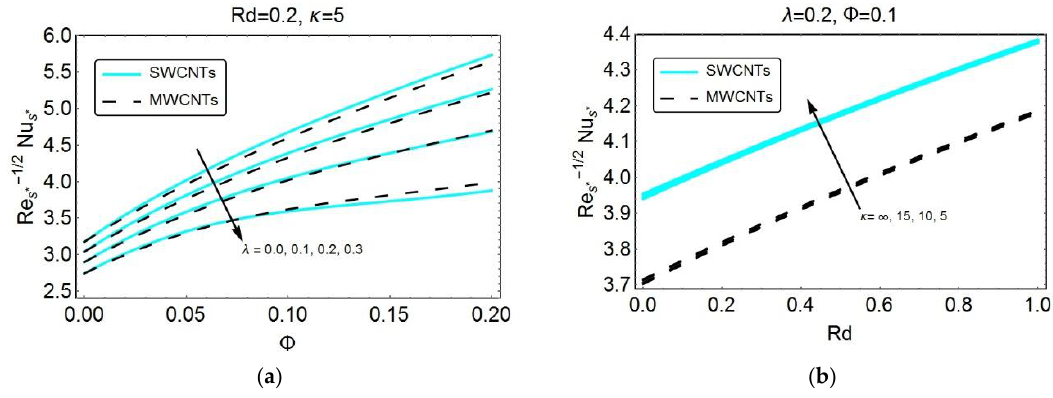
Figure 7. Nusselt number for some values of ( a ) 𝜆 ; ( b ) 𝜅 . Table 2. Variation in Thermo-physical properties of CNTs based